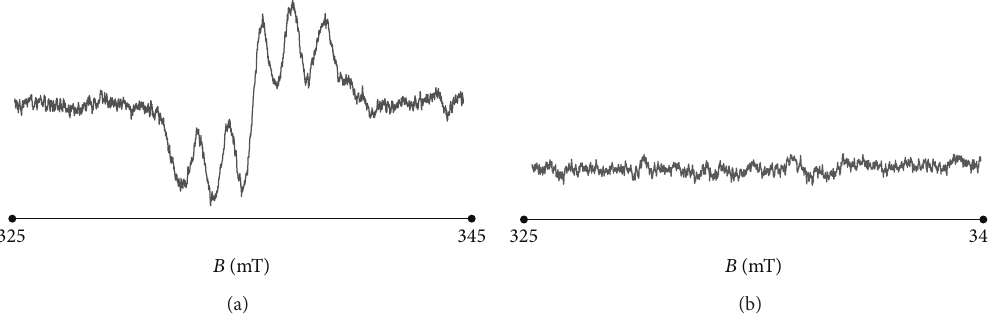
Figure 13: The EPR spectrum of (a) ethyl alcohol solution of DPPH and (b) the quenched line after addition of bismuth subgallate sterilized at temperature 180 ∘ C (30 minutes) to this